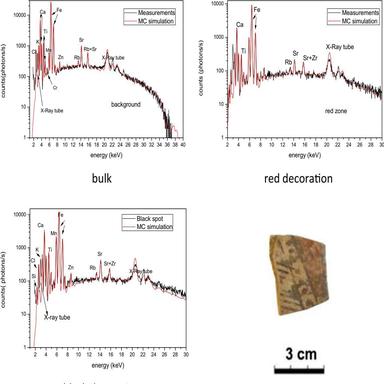
Comparison between X-Ray spectra obtained in the bulk, black and red decoration (sample Rip. 18). Note the logarithmic scale of the XRF spectra. (For interpretation of the references to color in this figure legend, the reader is referred to the web version of this article.)